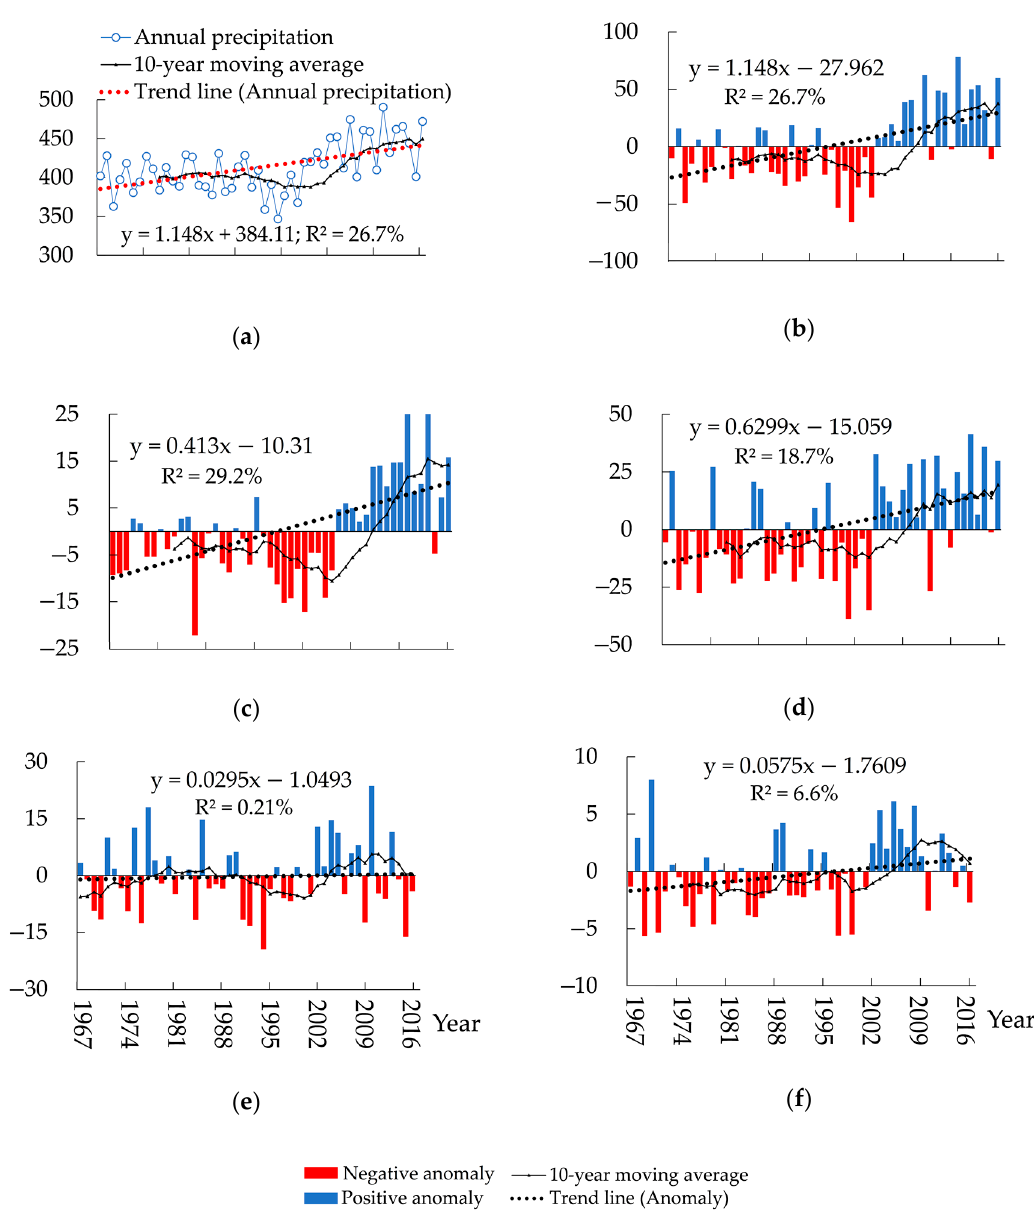
Figure 2. Variation of annual precipitation on the QTP during 1967–2016, the changes in annual and seasonal precipitation anomalies on the QTP. ( a ) Variation in annual precipitation; ( b ) annual precipitation anomaly; ( c ) spring precipitation anomaly; ( d ) summer precipitation anomaly; ( e ) autumn precipitation anomaly; ( f ) winter precipitation anomaly. Table 1. The average value of precipitation indifferent ages in the QTP (mm).